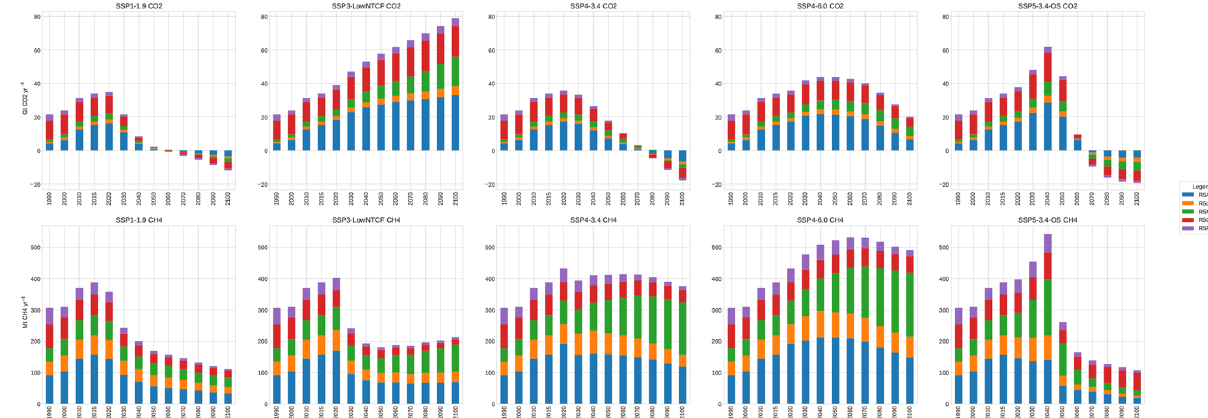
Figure G1. Emissions for five global regions for all other scenarios analyzed in this